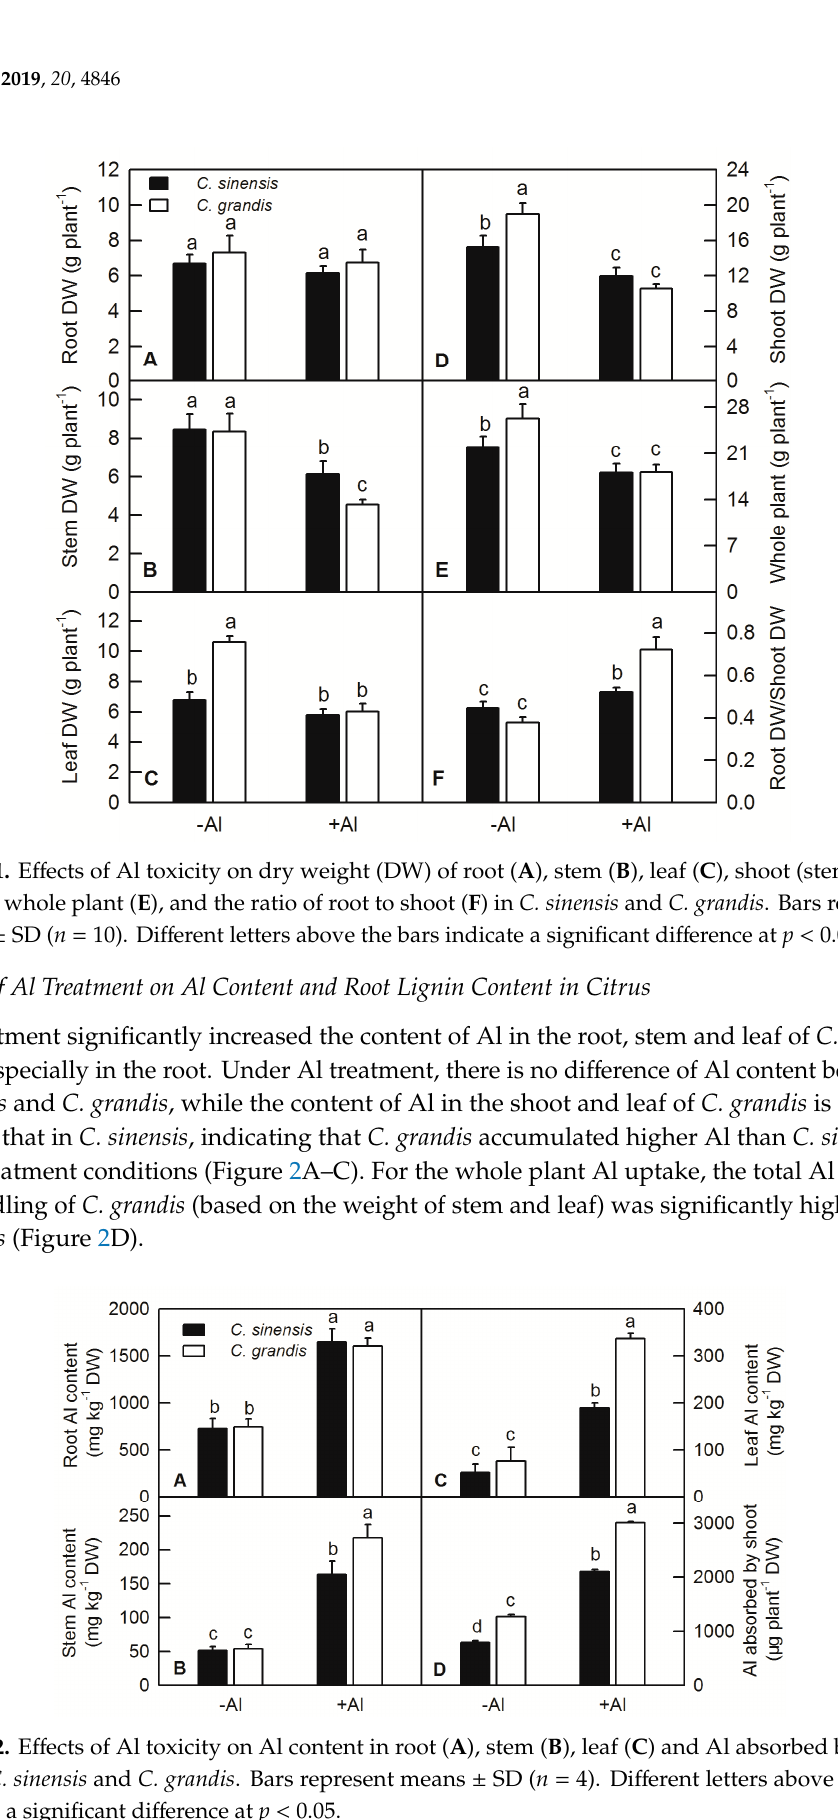
Figure 3. Effect of Al treatment on lignin content in roots of C. sinensis and C. grandis . Bars represent means ± SD ( n = 4). Different letters above the bars indicate a significant difference at p < 0.05. 2.3. Expression of ALS3 and CAD Genes in Citrus under Al Treatment The total RNAs were extracted from the roots of C. sinensis and C. grandis and relatively expression levels of ALS3 and CAD under Al treatment were measured by RT-qPCR. The results showed that the expression levels of ALS3 and CAD in C. sinensis and C. grandis were both increased under Al treatment (Figure 4).